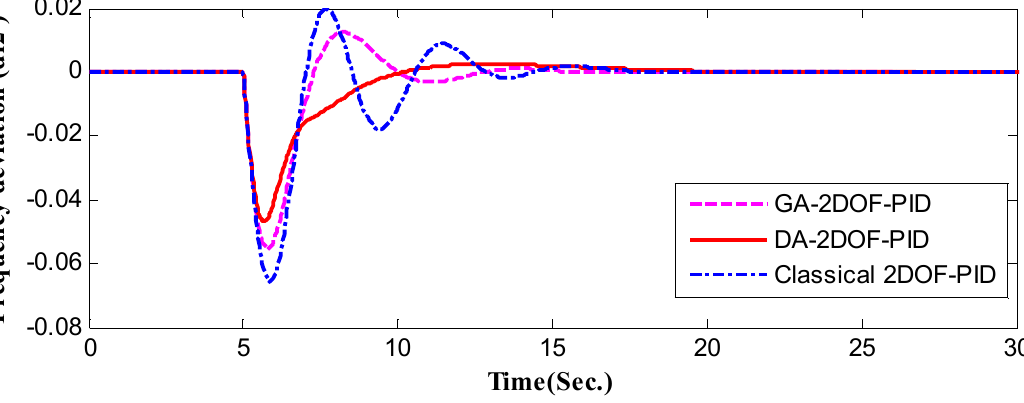
Figure 23. Δ P using GA-2DOF-PID, DA-2DOF-PID, and classical-2DOF-PID with ITAE.